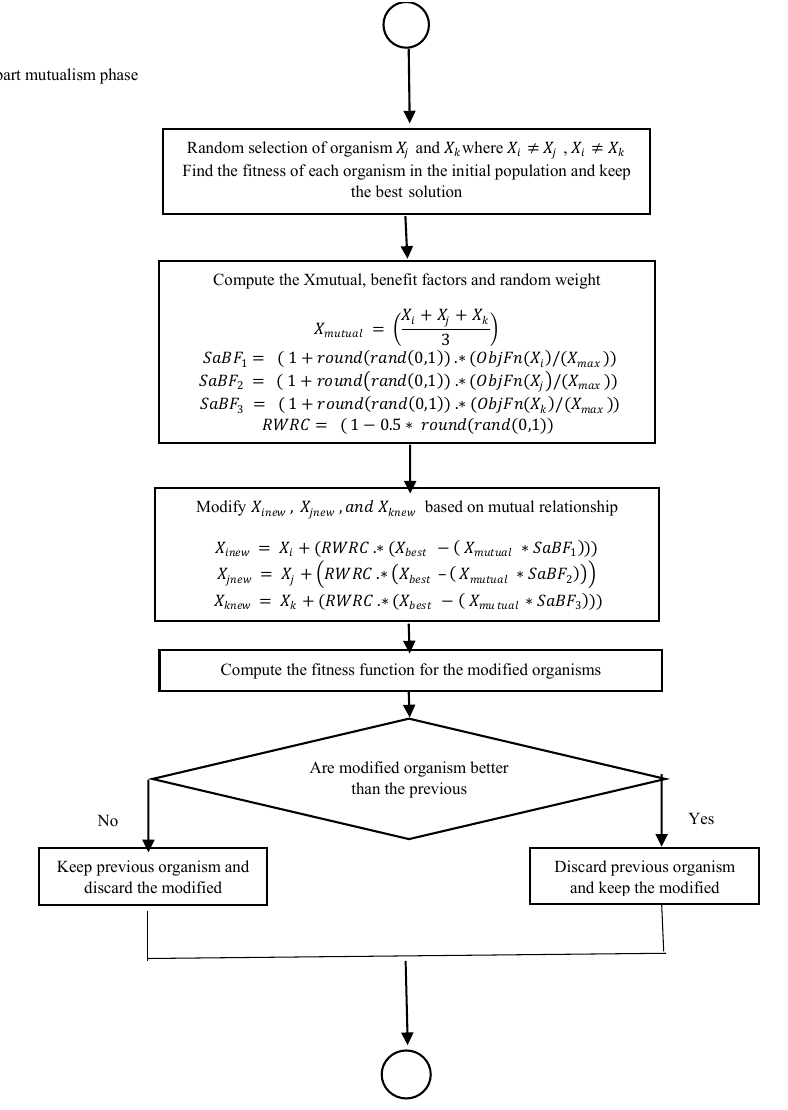
Figure 2. Flowchart for three-part mutualism phase.